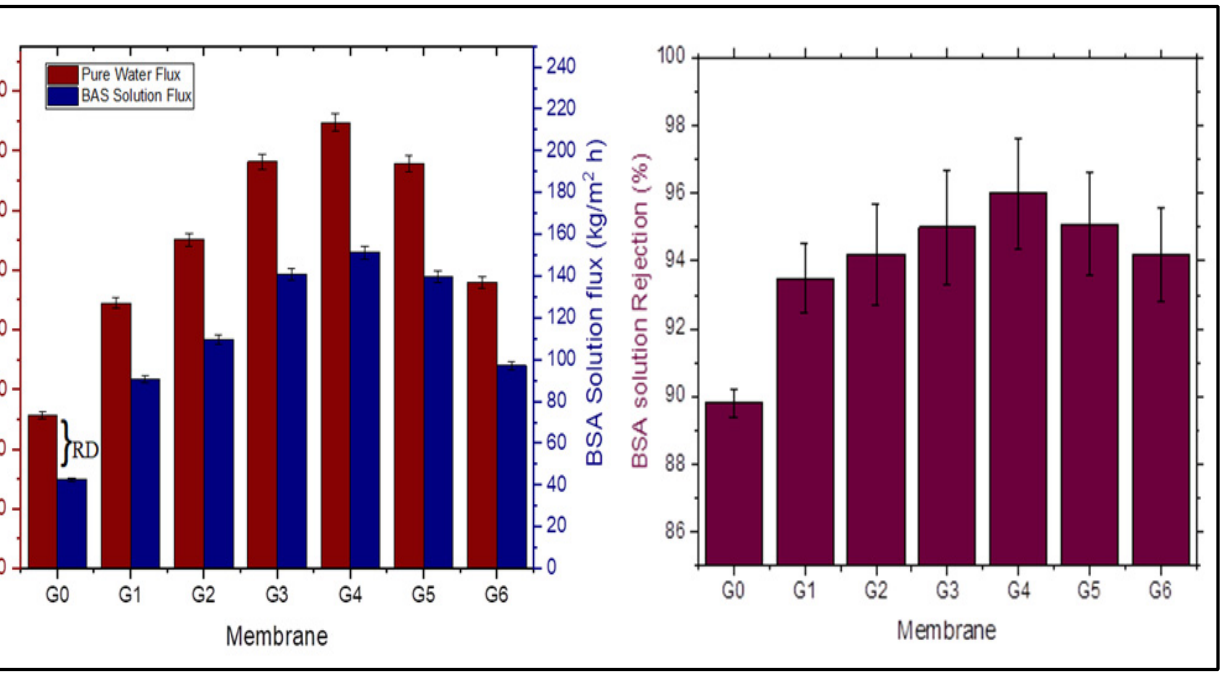
Figure 10. ( Left ) the water and BSA solution flux of the neat PES and PES/TGF membranes; flux reduction for G0 = 42%, G1 = 30%, G2 = 31%, G3 = 25%, G4 = 31%, G5 = 29%, and G6 = 29%. ( Right ) BSA solution retention for the neat PES and PES/TGF membranes.